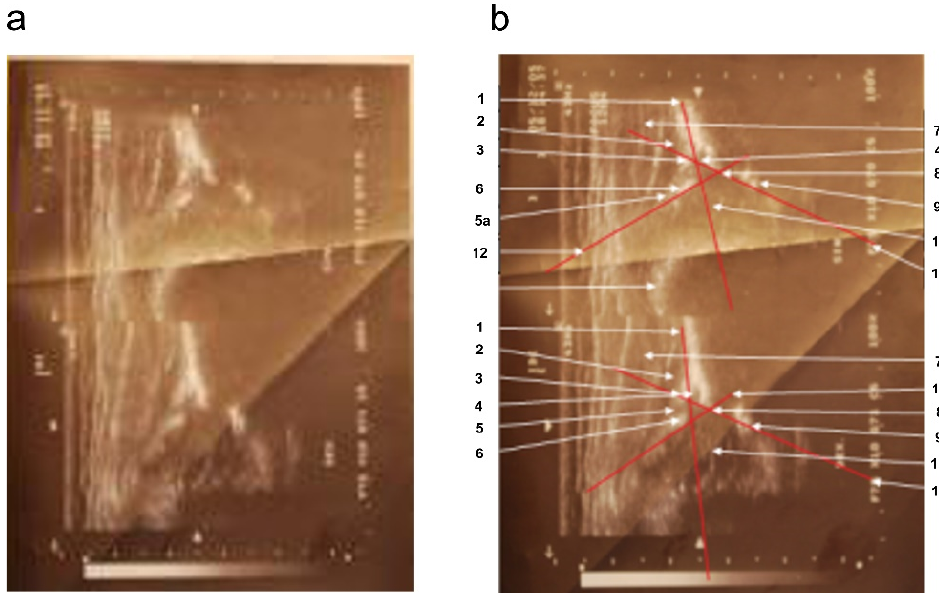
Figure 2. Sonograms of the girl’s hip joints at 9 weeks of age (second appointment). ( a ) Top part: left hip joint; alpha angle: 53°; beta angle: 74°; round bone edge. Type IIa according to Graf. Bottom: right hip joint; alpha angle: 63°; beta angle: 62°; acute bone edge type. Type Ib according to Graf. ( b ) Sonograms with overlay and description of anatomically important points. 1—baseline, 2—gluteus minimus muscle, 3—tendon of the femoral rectus muscle, 4—cartilage acetabular roof, 5—the disappearance of the joint capsule shadow in the region of the perichondrium defect in the adipose cushion; 5a—articular capsule, 6—acetabular labrum, 7—gluteus medium muscle, 8—bone edge (blunt type), i.e., turning point, 9—lower edge of the iliac bone, 10—cartilaginous femoral head with visualized vascular sinuses, 11—bone roofline, 12—cartilage roofline.